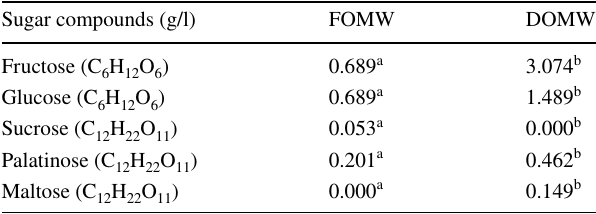
Table 4 Sugar concentration rate in FOMW and DOMW; Test Stu- dent was determined with FOMW and DOMW ( p = 0.14, p > 0.05)